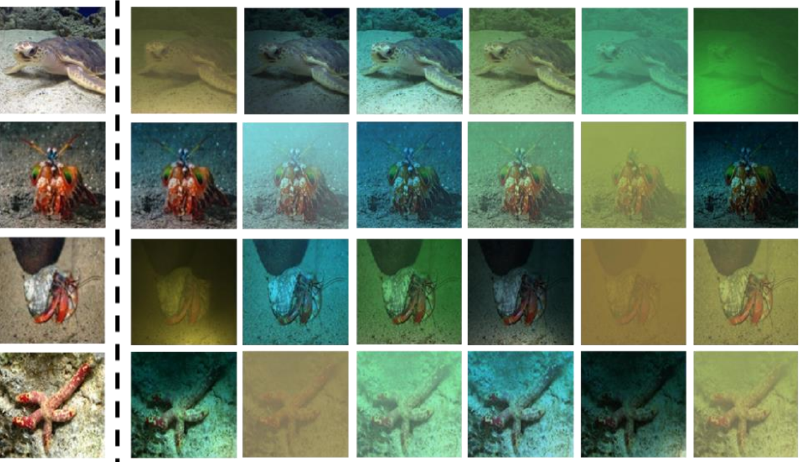
Figure 5. Samples of simulated underwater images generated by the proposed method. The first column presents clear images taken from the EUVP datasets, and the second to last columns are underwater images simulated based on the clear images in the first